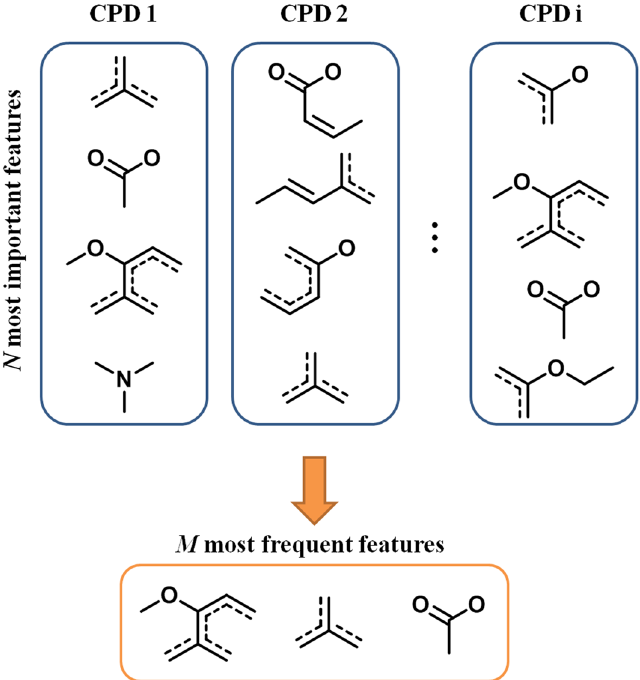
Figure 3. Feature extraction scheme. On the basis of SVs, the N most important features present in correctly predicted DT-CPDs were pre-selected and the M features occurring most frequently across these compounds were identified and prioritized.